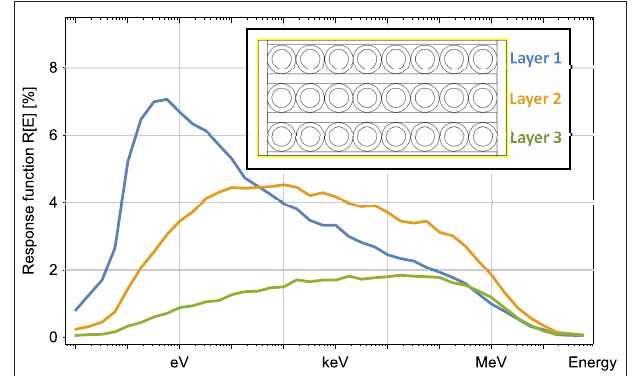
FIGURE 7 | Example for response function adaptation of the mobile unit that may be used for active signal correction of the near-field. Further layers increase the number of energy bands and allows to move toward characteristics of Bonner Sphere spectrometers. However, this calculation is valid for single side irradiation